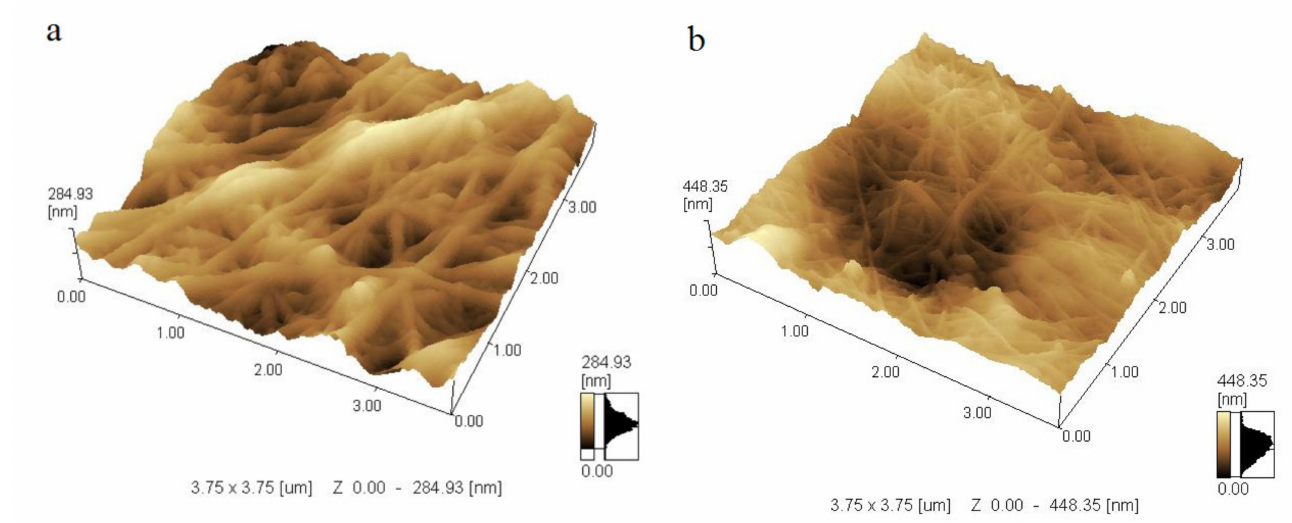
Figure 2. AFM images of cellulose microfibrils secreted into ( a ) HS medium and ( b ) molasses